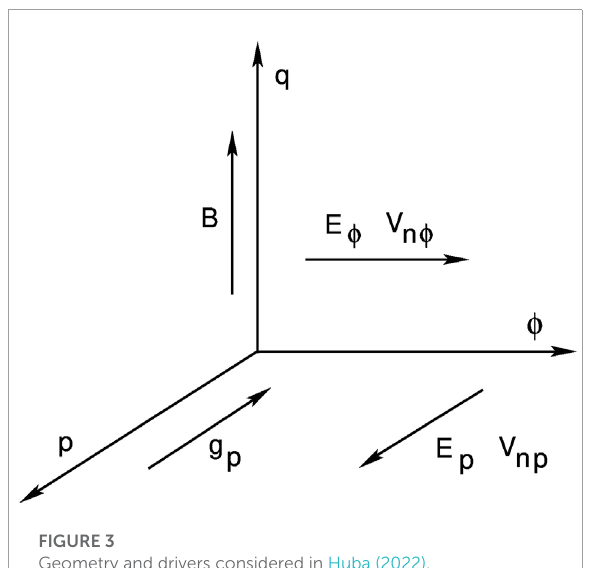
FIGURE 3 Geometry and drivers considered in Huba